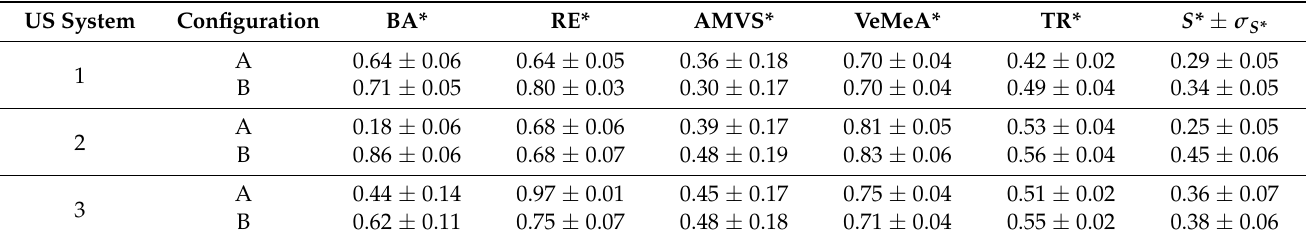
Table 15. Normalized QA test parameters and Kiviat diagram areas (mean ± SD) for systems 1, 2 and 3 equipped with convex array probes in configurations A and B at medium flow